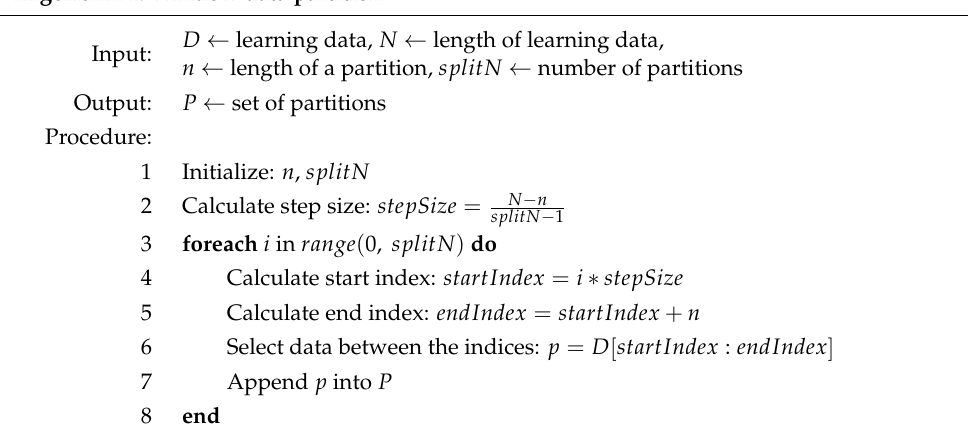
Algorithm 1. Window data